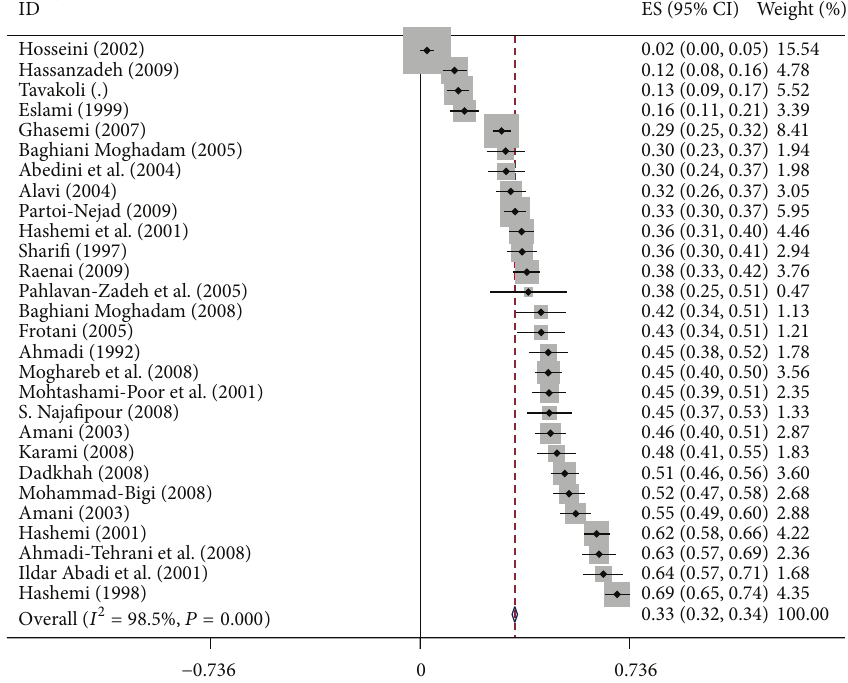
Figure 2: Forest plots of student depression for random effects meta-analyses. (Squares represent effect estimates of individual studies with their 95% confidence intervals of depression with size of squares proportional to the weight assigned to the study in the meta-analysis. The diamond represents the overall result and 95% confidence interval of the random-effects